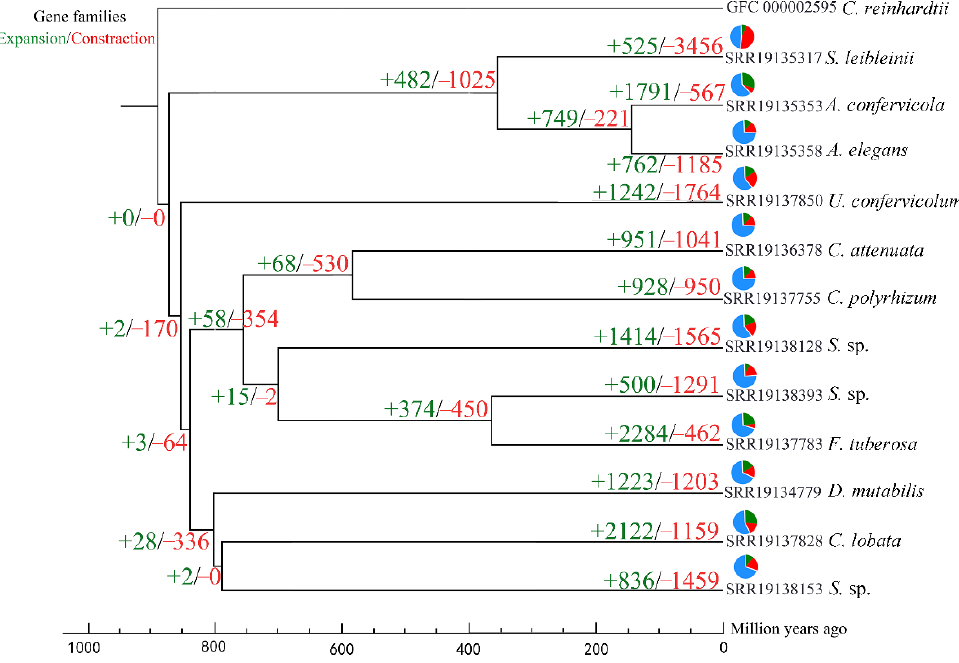
Figure 2. The branch numbers represent the number of gene families that have expanded (+) and contracted ( − ) since the common ancestor’s split. The relative ratio of expansion or contraction is shown on the pie chart. The timelines show the times at which the species diverged.